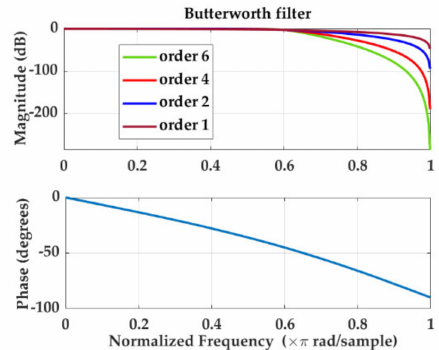
Figure 2. Bode plot for a lowpass Butterworth filter with a cuto ff frequency of 300 Hz (0.6 π rad / sample for data sampled at 1000 Hz). Di ff erent orders were simulated. ( bottom ): the phase response; ( top ): the